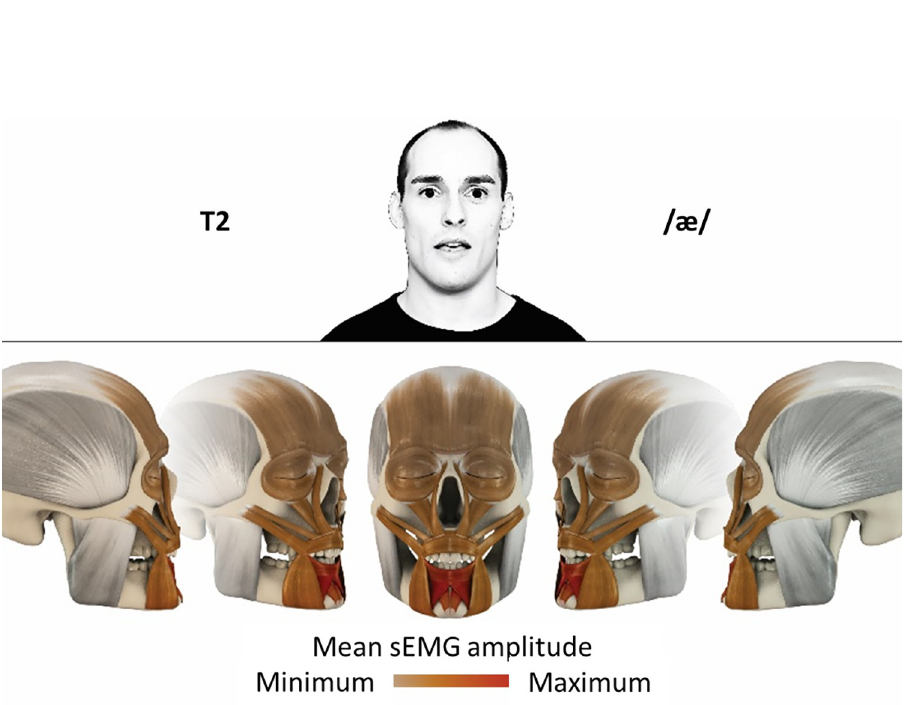
Fig 3. Color-coded facial muscle activation pattern of task T2. Pronouncing the German vowel: A¨/æ/. Animation by Jonas Laustro¨er.